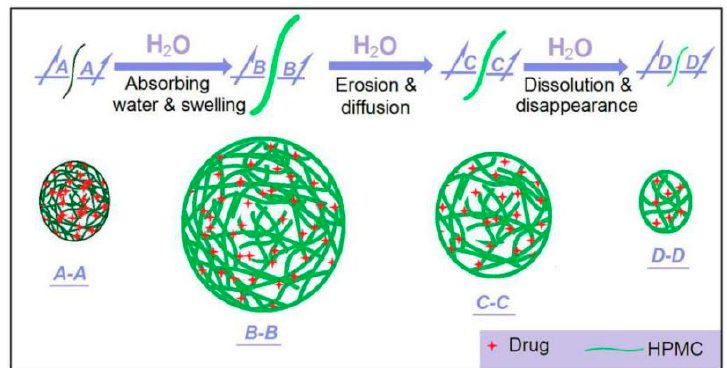
Figure 12. A diagram showing the drug dissolution mechanisms from the medicated ketoprofen (KET)-loaded nanofibers.